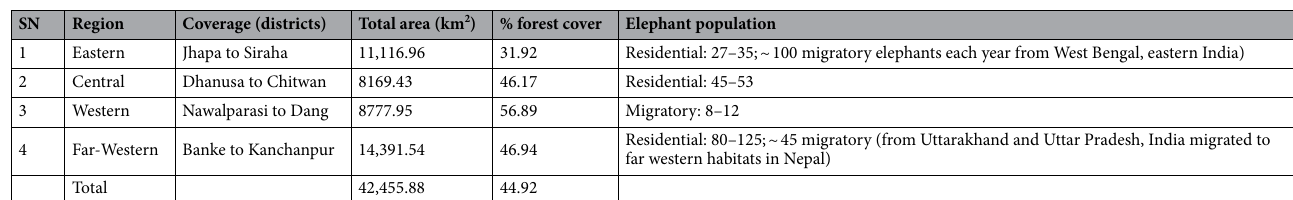
Table 5. Four different regions within Chure Terai Madhesh Landscape Nepal, area, forest cover and elephant population status. The elephant population was obtained from Ram and Acharya 80